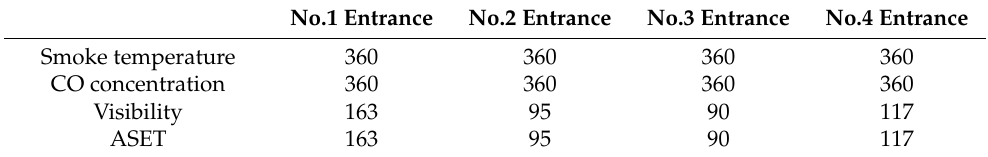
Table 5. ASET for the fire (unit: